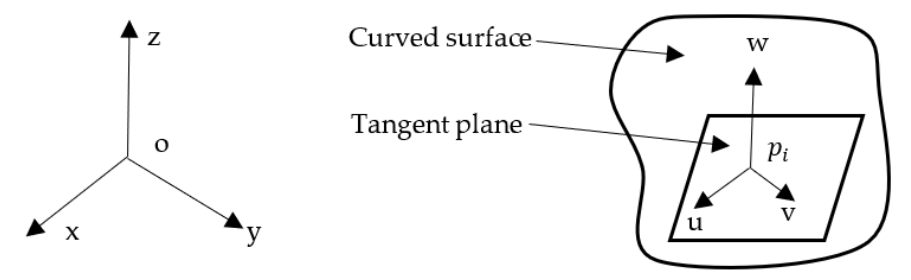
Figure 3. Local coordinate system.